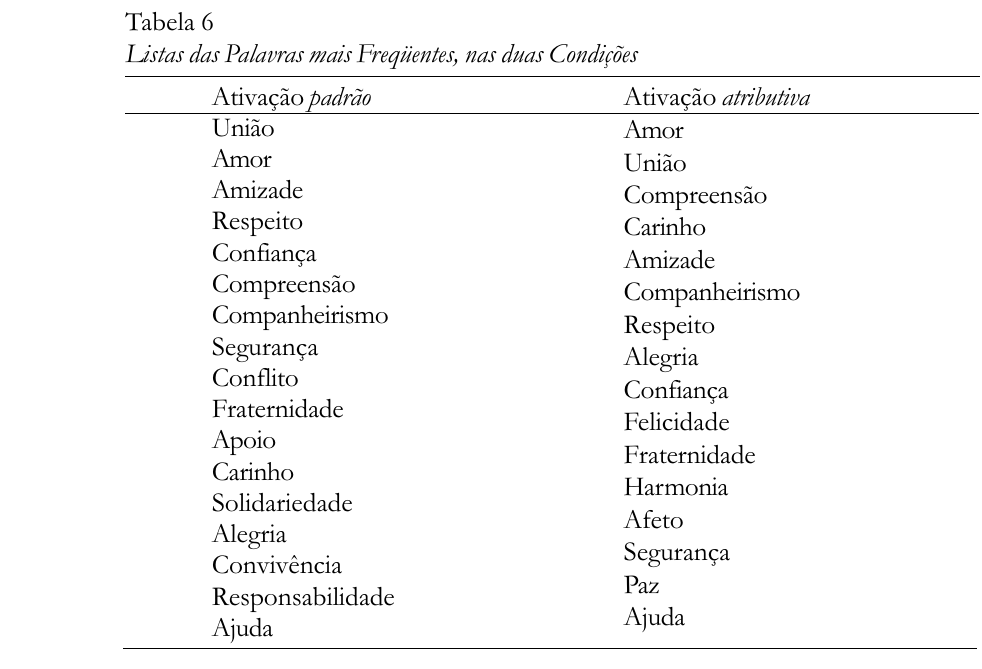
Questªo padrªo Questªo